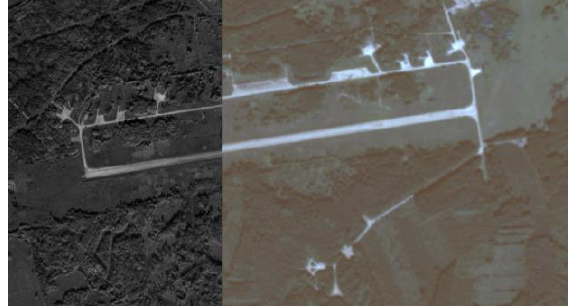
Figure 3. Full-color image and multispectral image overlay (1)